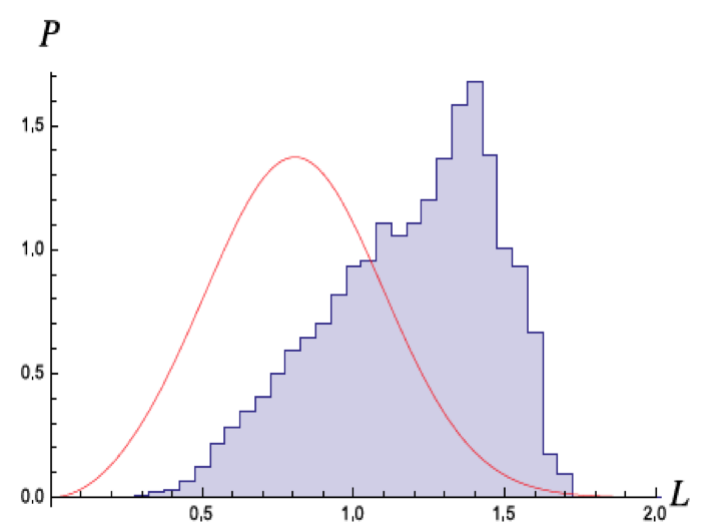
Figure 7. Distribution of the angular momentum L (in units of ¯ h ) from the numerical simulation of the SED dynamics reported in [4]. Not much weight lies below L = 0.588 , confirming that when such a value is reached at near-zero energy, self-ionisation may occur rapidly and the run is ended. Full curve: the distribution of L from the conjecture for the would-be stable ground state distribution from [24,25]. Figure from [24] with